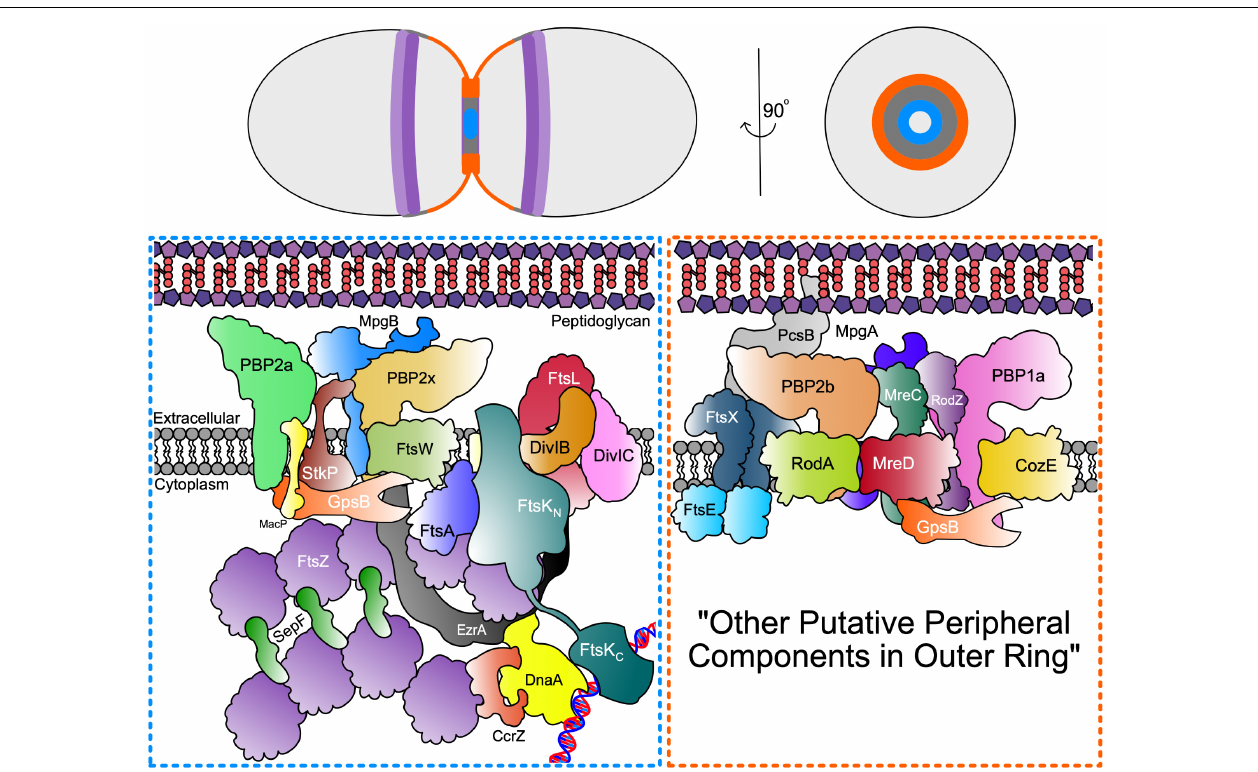
FIGURE 3 | Septal and Peripheral PG synthesis components. (Top) Organisation of FtsZ Ring (dark purple) and MapZ ring (light purple) as well as septal (blue) and periphery (orange) PG synthases represented across the longitudinal and transverse plan of the pneumococcal cell. (Bottom) Schematic representation of the spatial and functional separation of divisome machinery between septal (blue box) and peripheral (orange box) machinery located in the inner and outer PG synthesis rings at opposite edges of the midcell annular disk. The organisation of the outer peripheral ring is unknown and may contain additional components, thus denoted here as “other putative peripheral components in outer